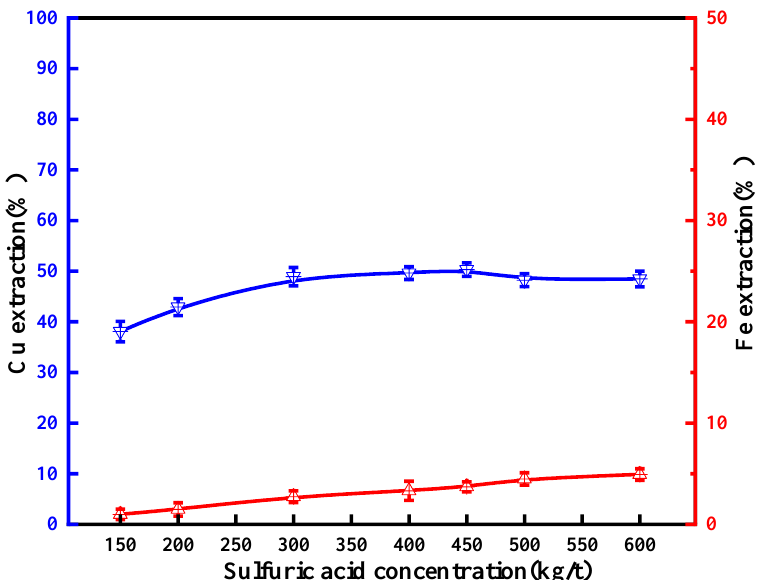
Figure 7. Effect of sulfuric acid concentration on metal extractions in agitation leaching.